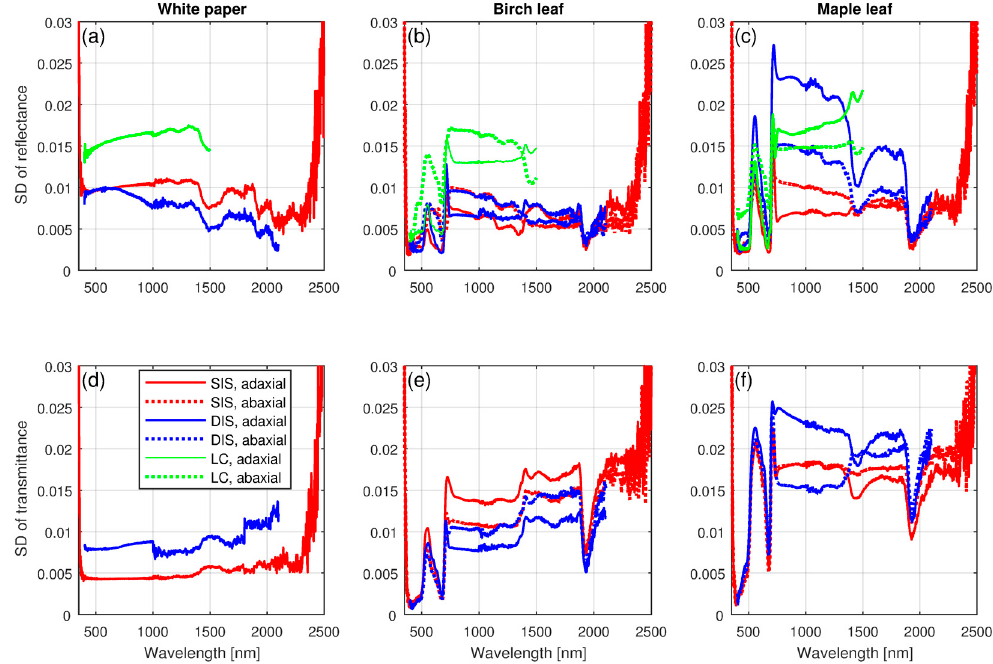
Figure 2. Standard deviations (SD) of reflectance and transmittance spectra of white paper, birch leaves, and maple leaves measured with different methods. SIS = single integrating sphere, DIS = double integrating sphere, LC = leaf clip. Upper row ( a – c ): Reflectance; lower row ( d – f ): Transmittance.